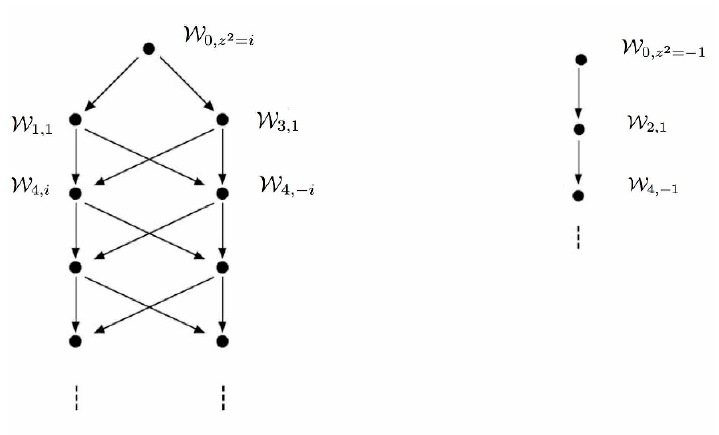
Figure 9 . The simple modules X 0 ;i and X 0 ; (cid:0) 1 are the tops of these two diagrams representing the structure of the standard modules for q = e i(cid:25)= 4